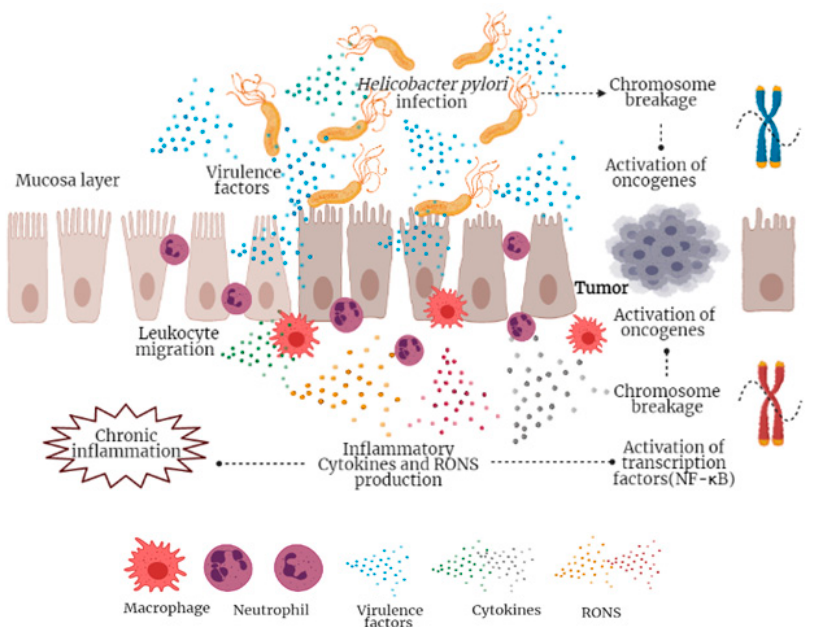
Figure 3. Mechanisms in the pathogenesis of Helicobacter pylori ‐ associated gastric carcinogenesis.